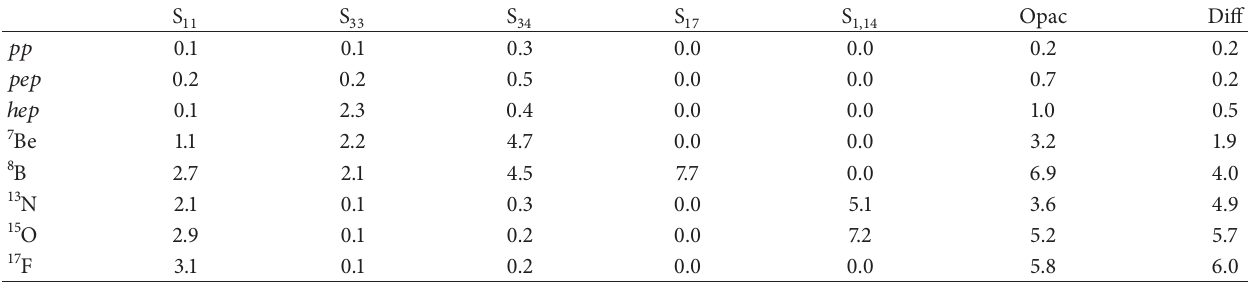
Table 5: Percentage contribution of selected individual sources of uncertainty to the neutrino